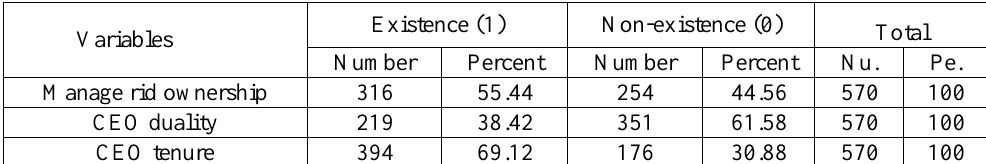
Table 2, The Frequency of dual variables according to total